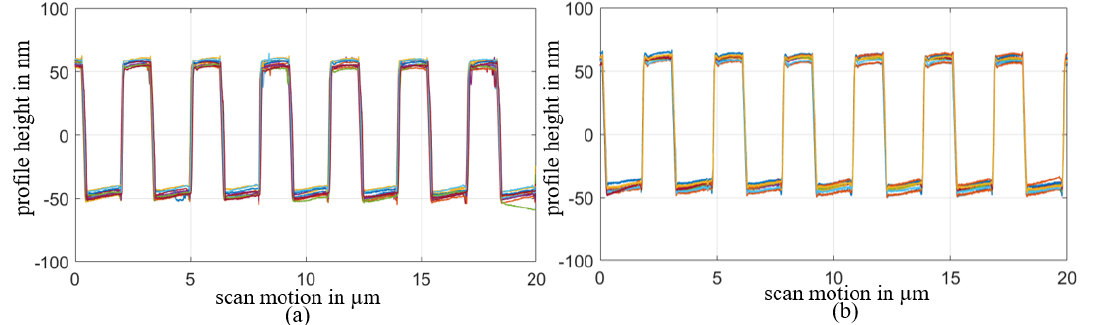
Figure 12. Section of the scanned 14 lines (a) and repeatedly (10 times) scanned profile of one line (b) .